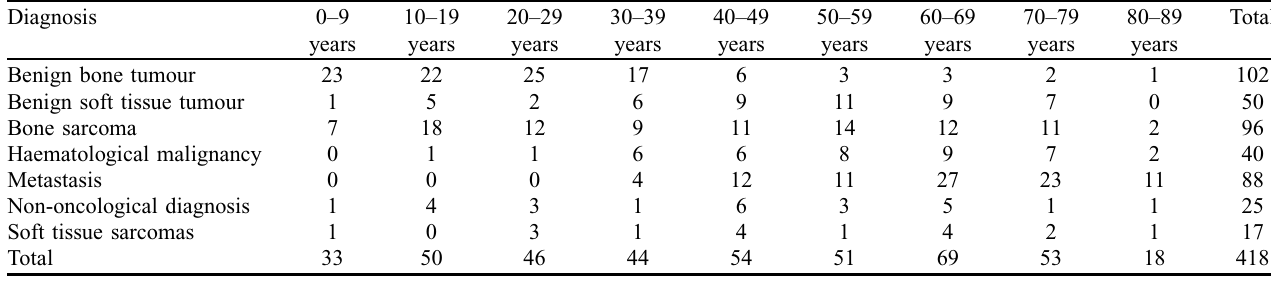
Table 1. Distribution of different lesions of the scapula in various age groups.